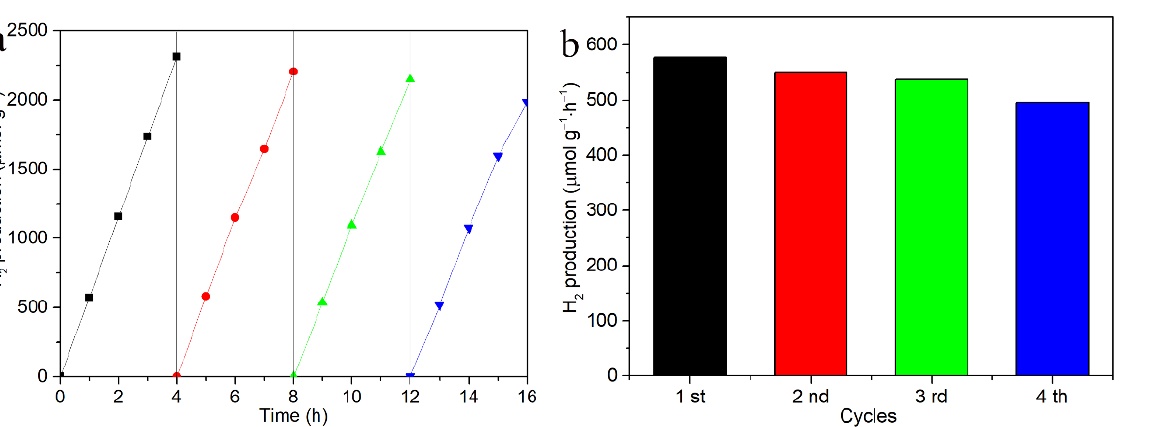
Figure 9. Photocatalytic stability of CF/SrTiO 3 /CdS-2 composite fiber, ( a ) cycle curve of hydrogen production amount, and ( b ) the corresponding histogram.